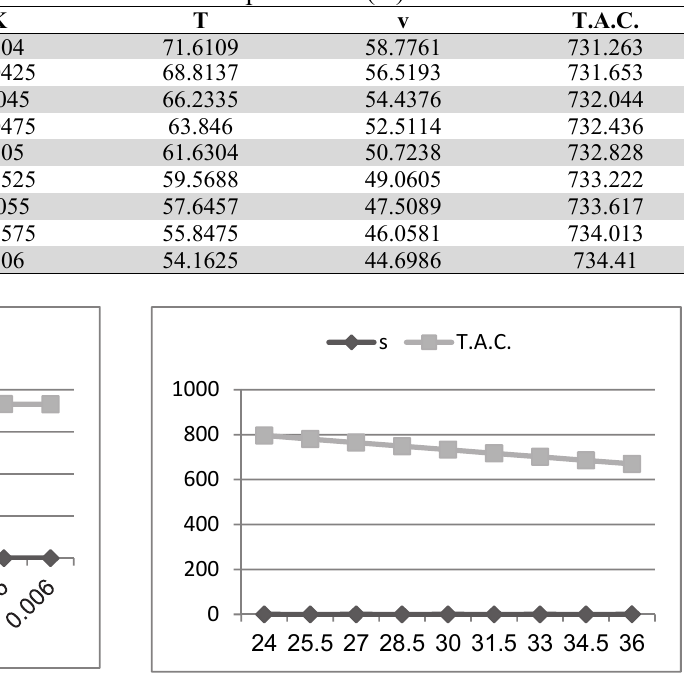
Effect on optimal solution for distinct values of deterioration parameter (K)